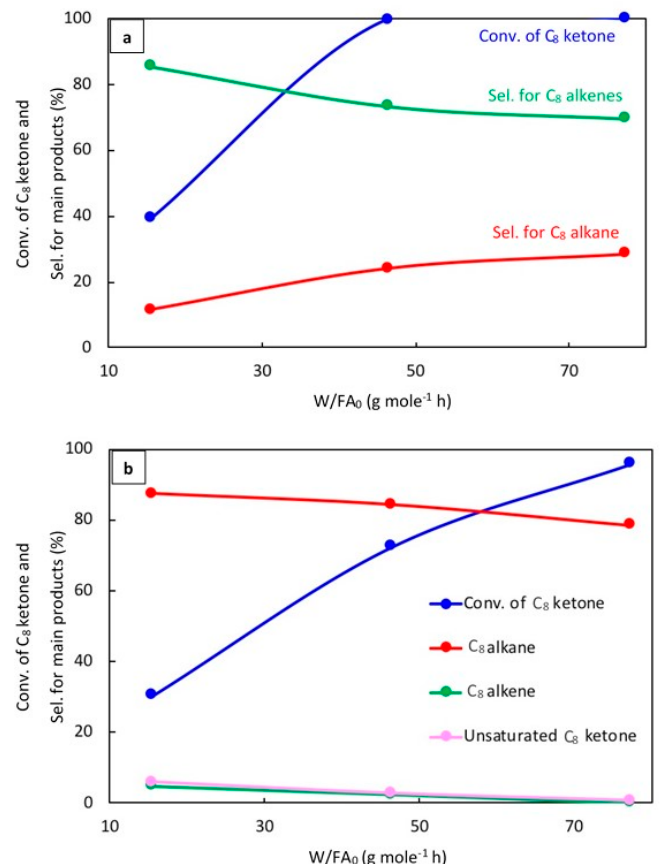
Figure 6. Catalytic results for the conversion of the C 8 ketone to several products with different space times after 1 h of the reaction over ( a ) (20% Cu-Al 2 O 3 ), and ( b ) (1% Pt-Al 2 O 3 ). Reaction conditions: reaction temperature of 220 °C; total flow rate of H 2 and N 2 of 85 mL/min; flow rate of C 8 ketone of 1 mL/h; molar ratio of H 2 /C 8 ketone of 5; and a calcination time of 4 h.